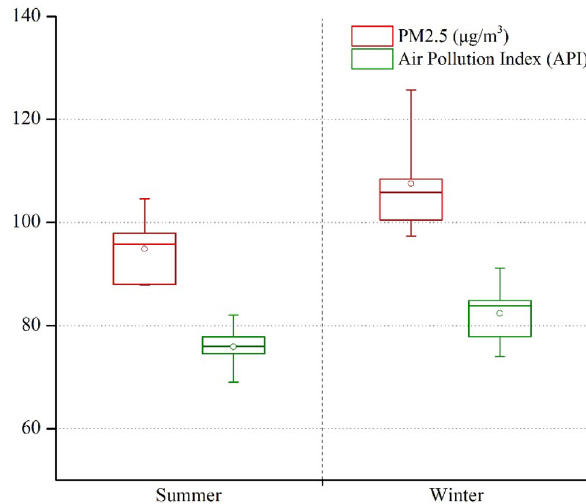
Fig. 6 Average level of PM2.5 and Air Pollution Index (API) in summer (June, July, and August) and winter (December, January, and February) of Beijing from 2007 to 2012. The dashes and open-circles in the boxes are the median and mean values. Boxes and whiskers present 25 to 75 and 10 to 90 percentiles of seasonal pollutants over 2007–2012. Data source Daily PM2.5 levels were recorded by